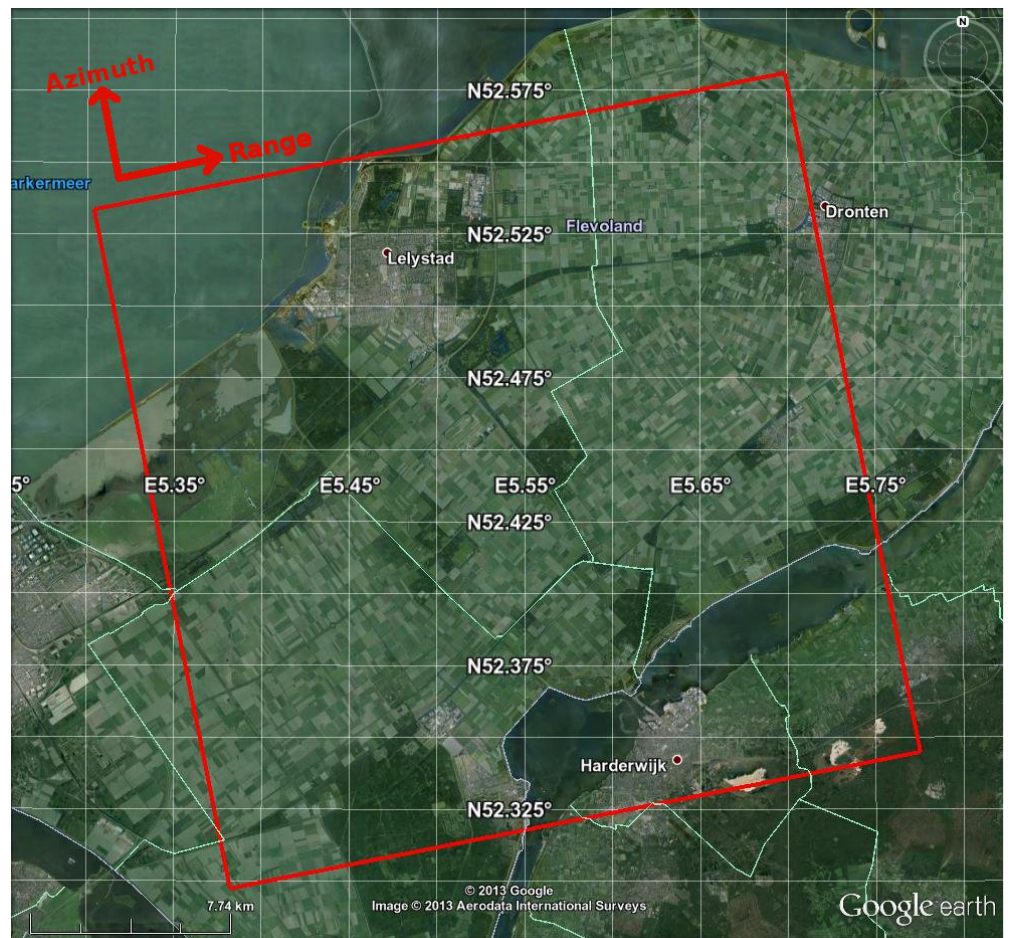
Figure 3. Optical image of the scene with the acquisition area marked in red [27]. The center of the imaged area corresponds to coordinates 52 . 439 ◦ N, 5 . 539 ◦